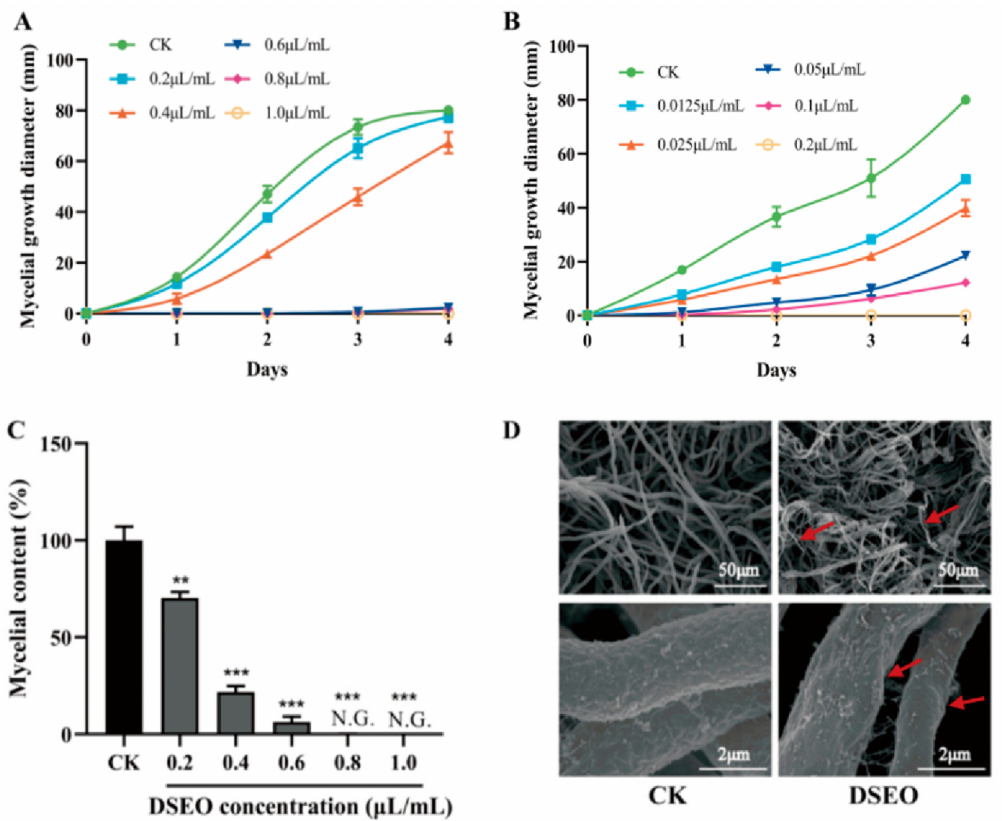
Figure 1. The effect of DSEO on N. parvum growth. ( A ) The effect of DSEO on N. parvum growth in potato dextrose agar (PDA) medium by direct contact assays; ( B ) The effects of DSEO fumigation on the growth of N. parvum in PDA medium by vapor contact assays; ( C ) The effect of DSEO on N. parvum growth in potato dextrose broth (PDB) medium, the growth of fungi was shown by the dry weight of mycelium. N.G., No growth. ( D ) Scanning electron microscopy (SEM) images of N. parvum with or without DSEO (0.8 µ L/mL) treatment. Clear changes were marked with arrows. “CK” represents “control”. Statistical significance was set at ** p < 0.01, *** p <